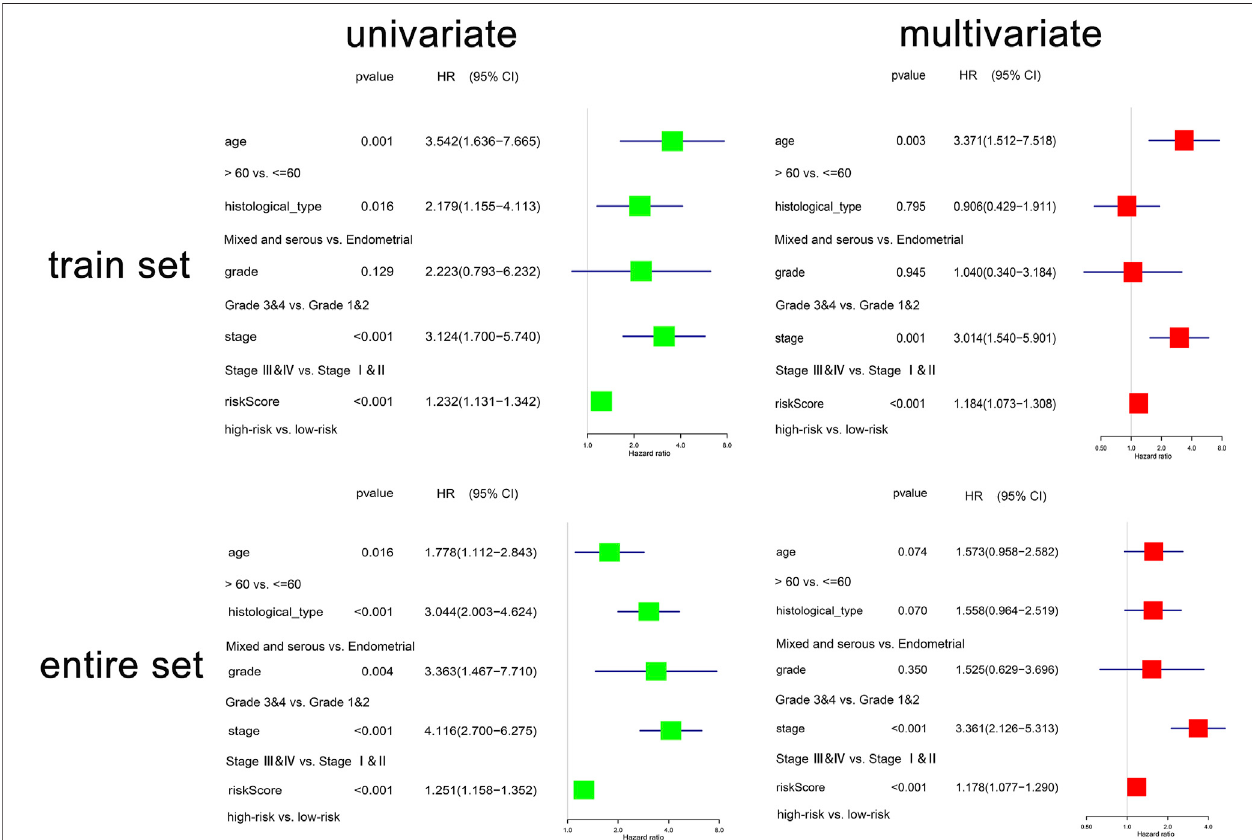
FIGURE 3 | The regression analyses of the independent predictor of uterine corpus endometrial carcinoma (UCEC). In the train set, N (cid:1) 256; in the entire set, N (cid:1) 511.